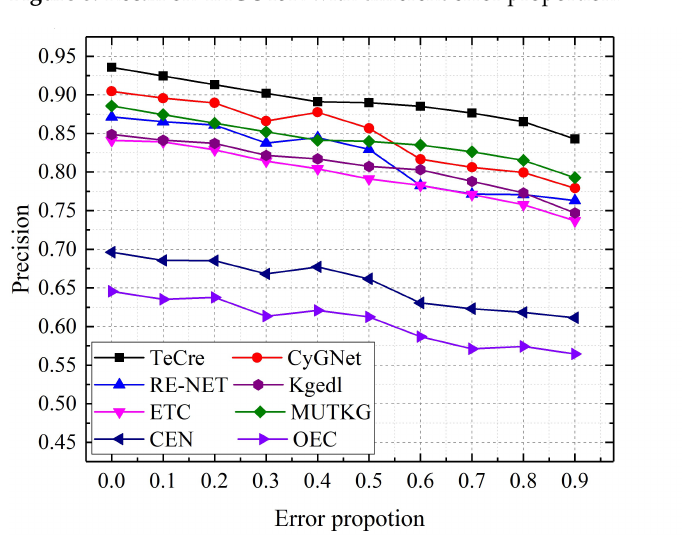
Figure 9. Precision on ICEWS’14 with different error proportion.